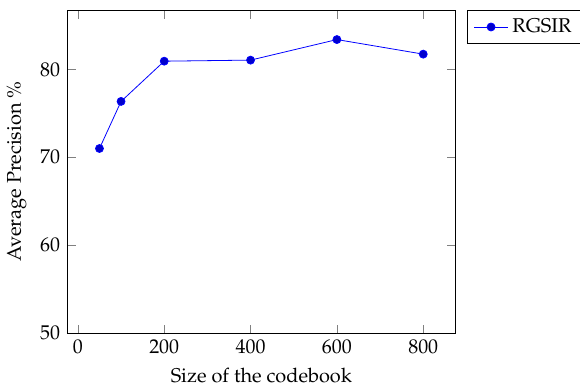
Figure 9. Average Precision as a function of vocabulary size.